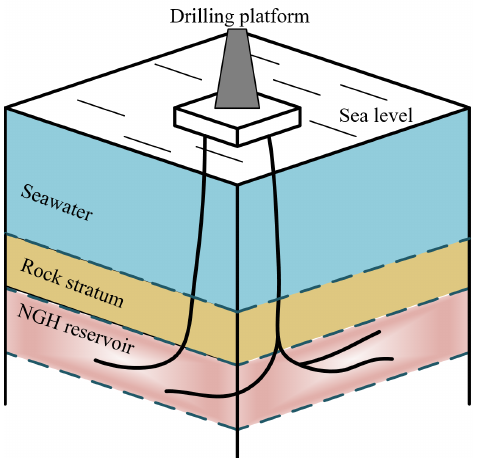
Figure 2. NGH exploration through offshore drilling